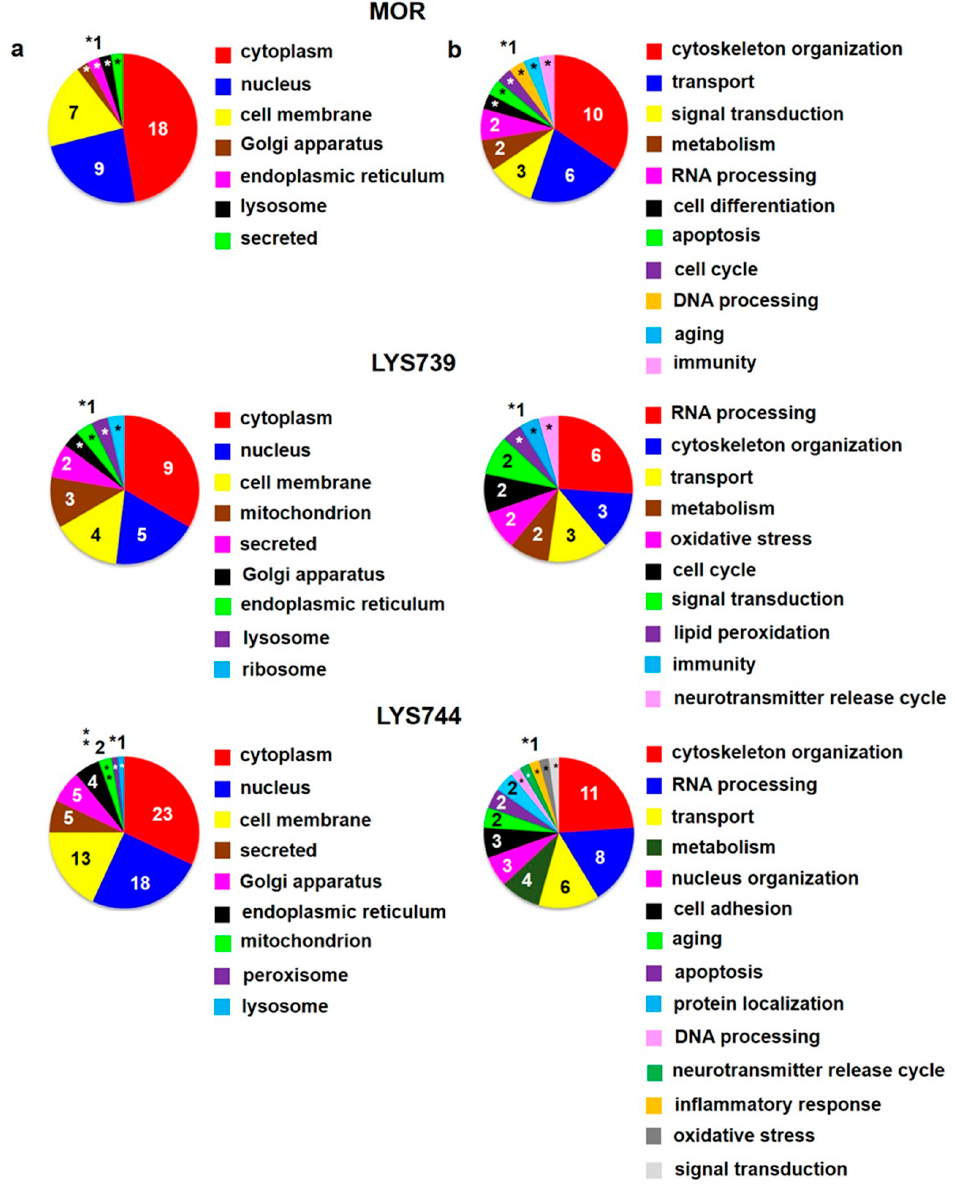
Figure 1. Subcellular localization ( a ) and function ( b ) of significantly altered proteins (at least 2-fold) identified in rat spleen lymphocytes after 7-day treatment with 3 mg/kg of morphine ( MOR , upper panels), LYS739 ( middle panels), and LYS744 ( lower panels); according to the current annotations in the Uniprot database (https://www.uniprot.org, accessed on 28 January 2022). The numbers represent proteins found within each subcellular localization and functional category, *1, **2.